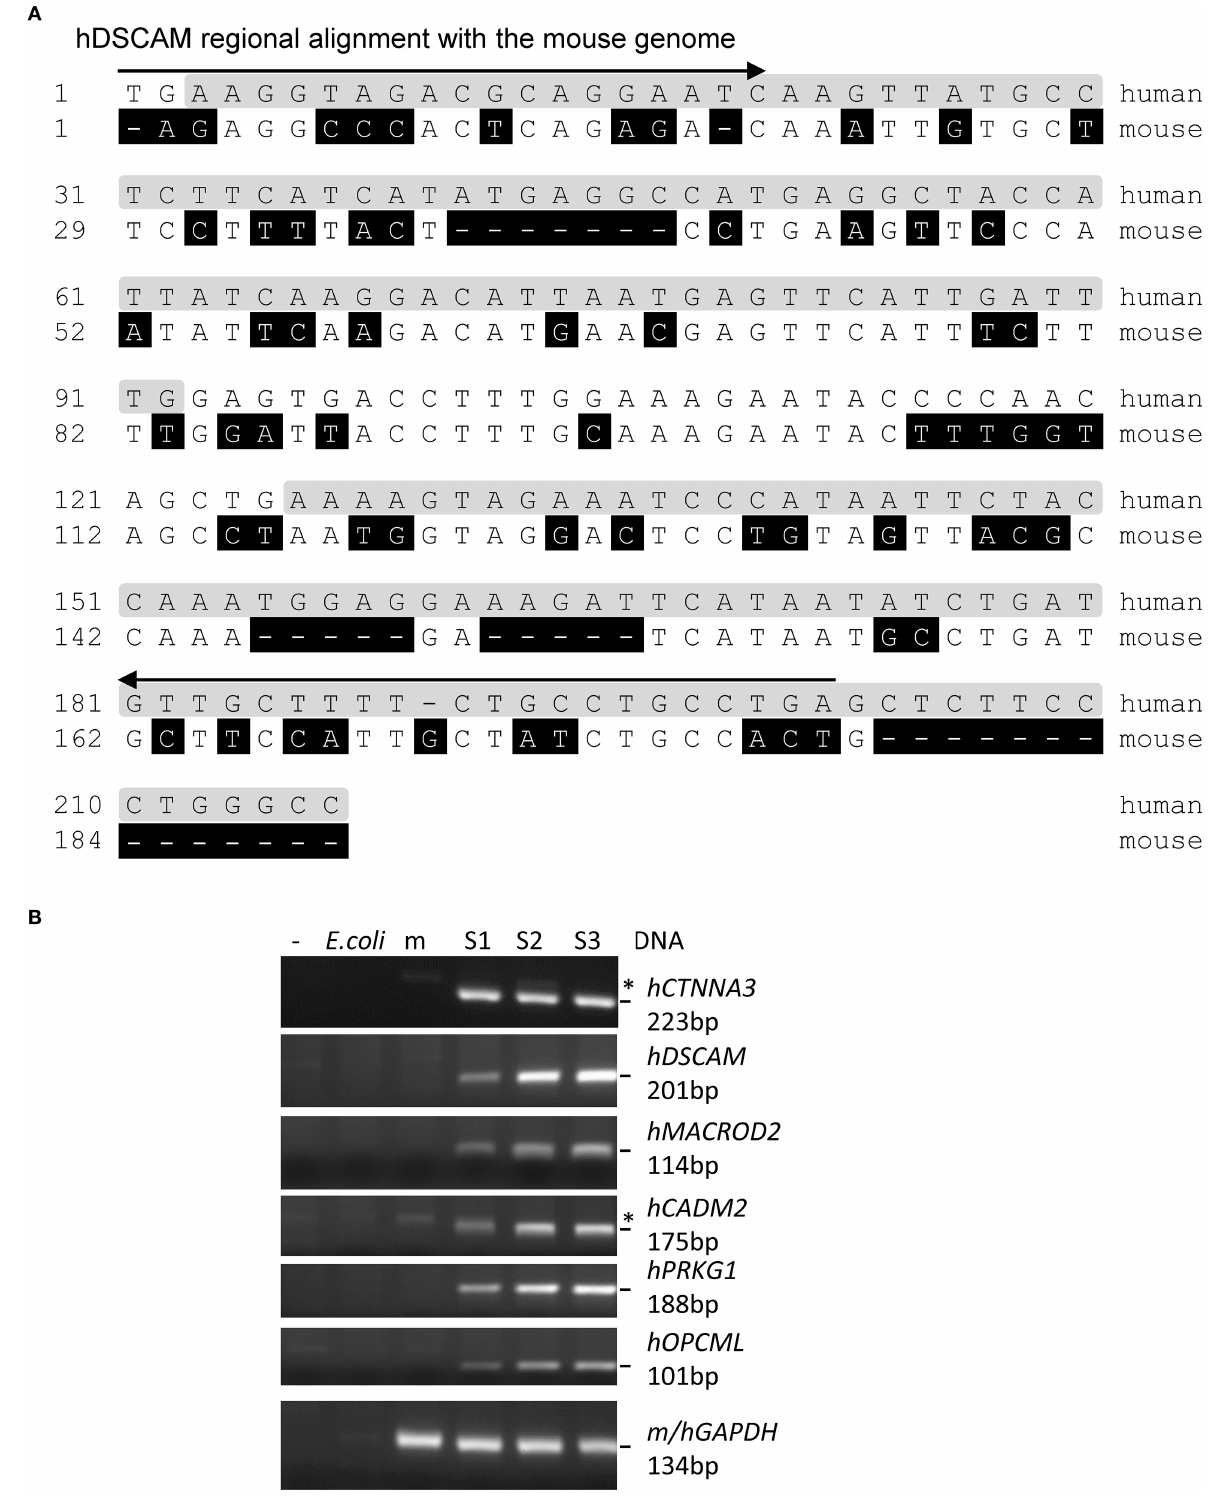
Frontiers in Oncology |